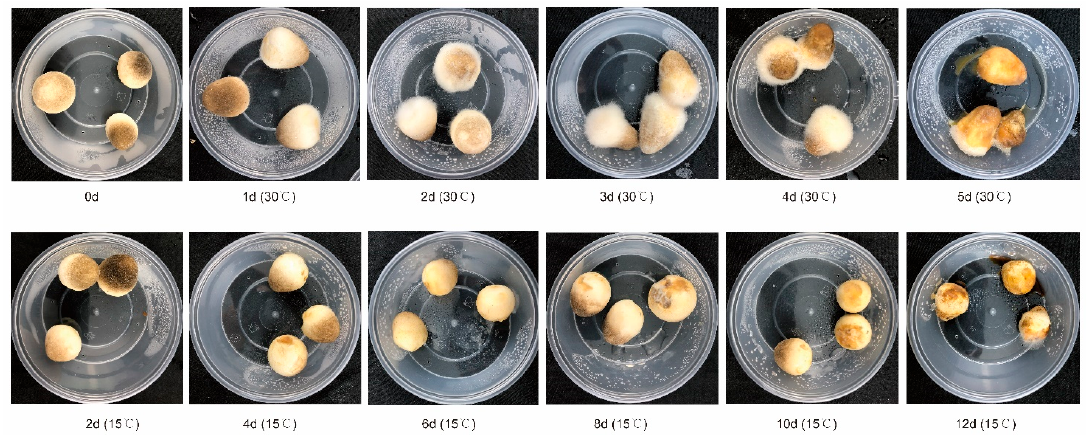
Figure 1. The sensory quality of the V. volvacea fruit bodies stored at 30 and 15 °C.